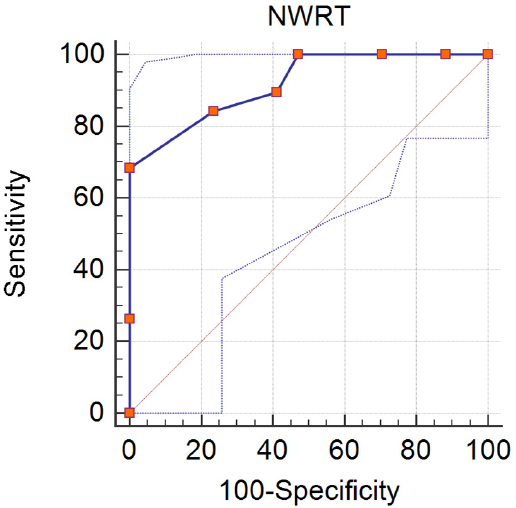
Figure 6. ROC curve for NWRT (distinction between phonological risk, n = 19, and no risk, n = 15), AUC = 0.918.